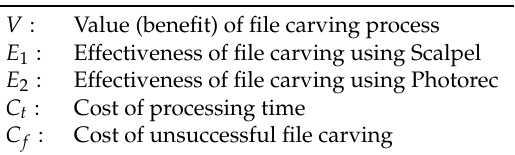
Table 3. Definition of the parameters.